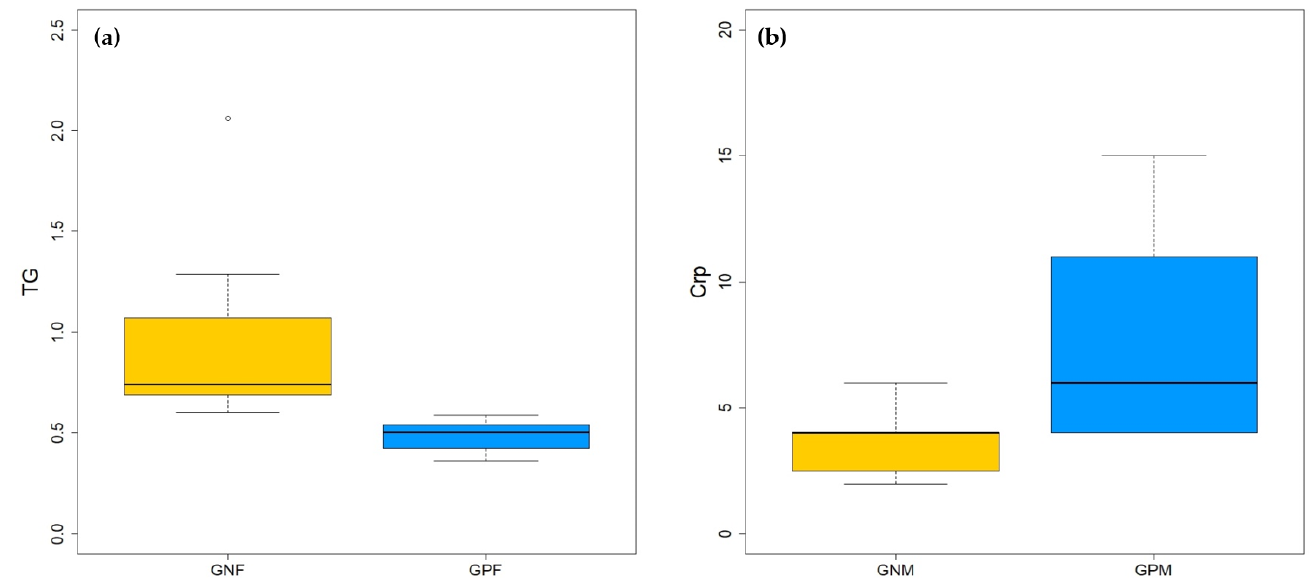
Figure 5. Box plot of the significant hematological and biochemical parameters in ( a ) female and ( b ) male dogs. TG is expressed in mmol/L, CRP in mg/L.